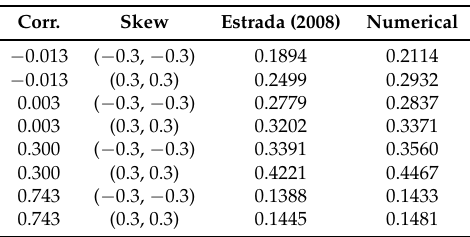
Table 2. Sortino ratio of mean-semivariance portfolios with multivariate skew normal returns and 240 months rolling windows. Benchmark = risk-free rate (0.1%).